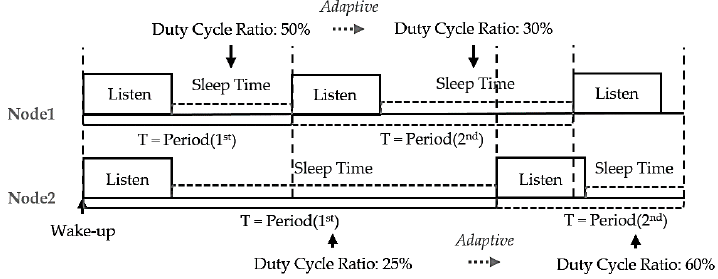
Figure 4. Proposed adaptive duty-cycled hybrid X-MAC protocol.